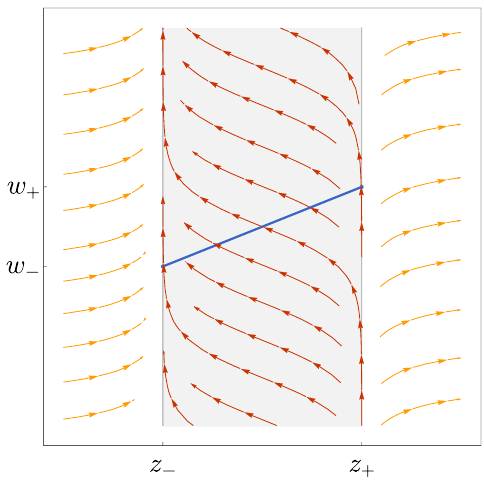
(blue line) lies A